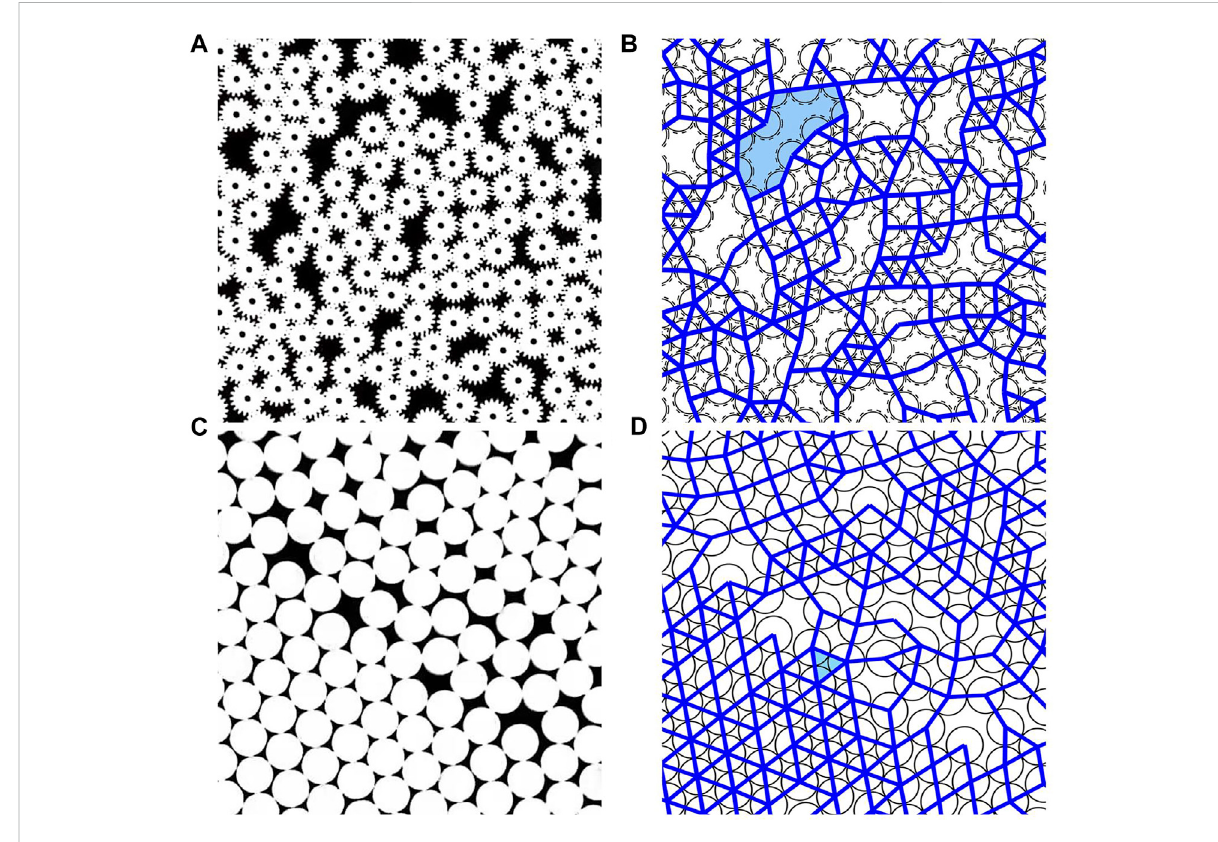
FIGURE 2 Particlecharacterizationdiagram; (A) Initialimageofgearparticles; (B) Characterizationresultofgearparticles; (C) Initialimageofdiskparticles; (D) Characterization result of disk